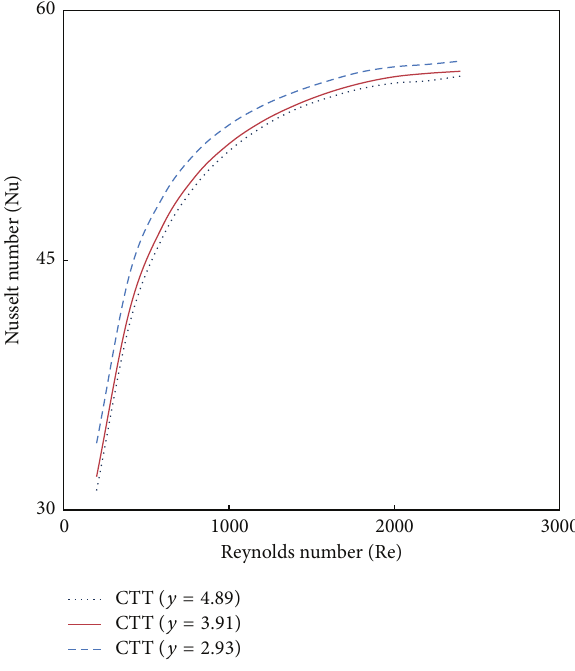
Figure 5: The effect of twist ratio ( y ) on Nusselt